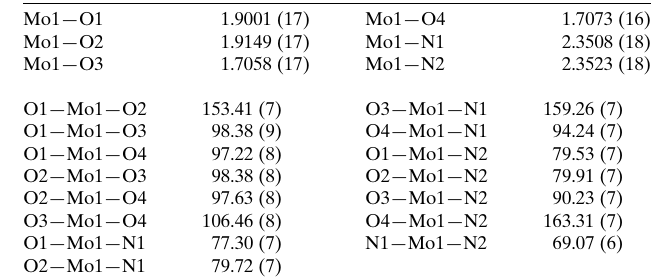
Table 1 Selected geometric parameters (A˚ , (cid:3) ).